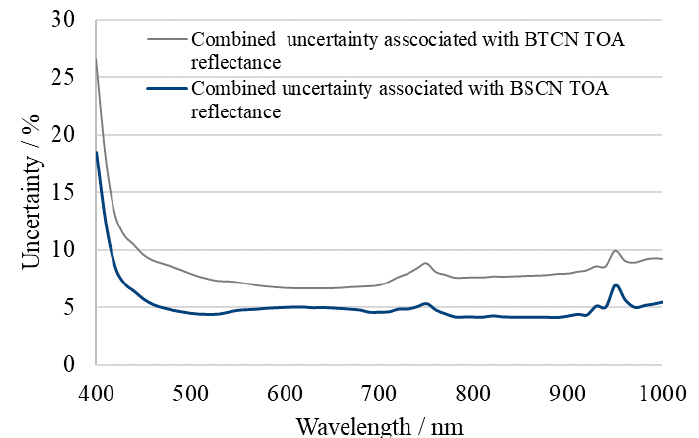
Figure 16. The combined uncertainty associated with propagation to top-of-atmosphere reflectance.